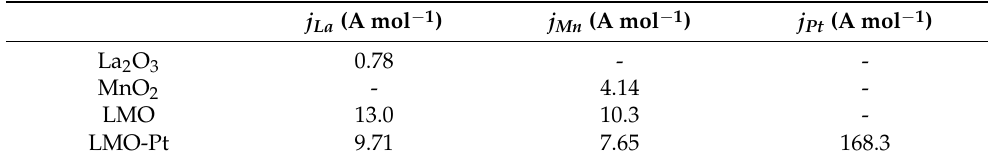
Table 1. The current densities per mol of a metal for La 2 O 3 , MnO 2 , LMO, and LMO-Pt electrolytic material in O 2 -saturated 0.10 M